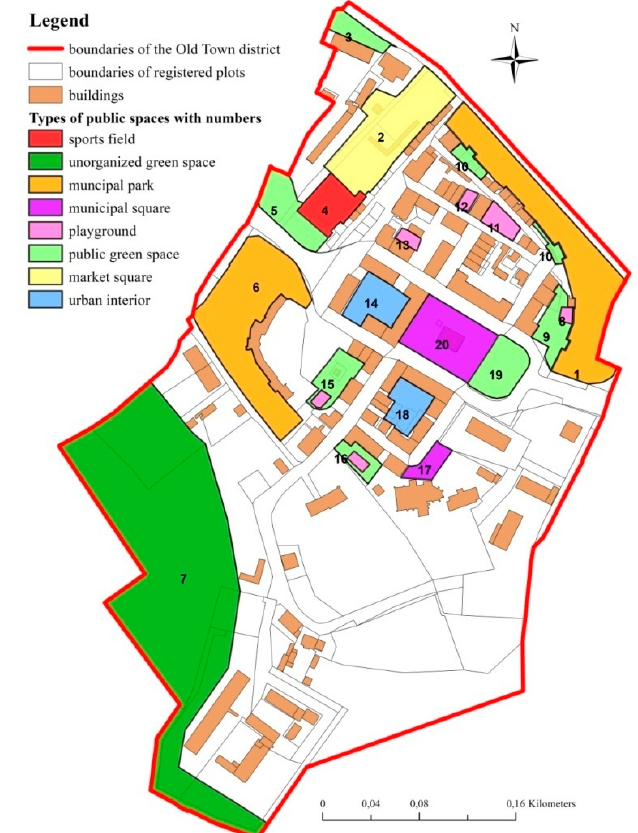
Figure 3. Distribution of public spaces in the center of Mor ą g. Source: own elaboration. Description of public spaces: 1. Historical municipal park; 2. Market square; 3. Public green space; 4. Sports field; 5. Public green space; 6. Municipal park (behind Dohn Palace); 7. Unorganized green space; 8. Playground; 9. Public green space; 10. Public greens and recreational areas; 11. Playground; 12. Playground; 13. Playground; 14. Urban interior; 15. Playground with public green space; 16. Playground with public green space; 17. Municipal square. 18. Urban interior; 19. Public green space; 20. Municipal